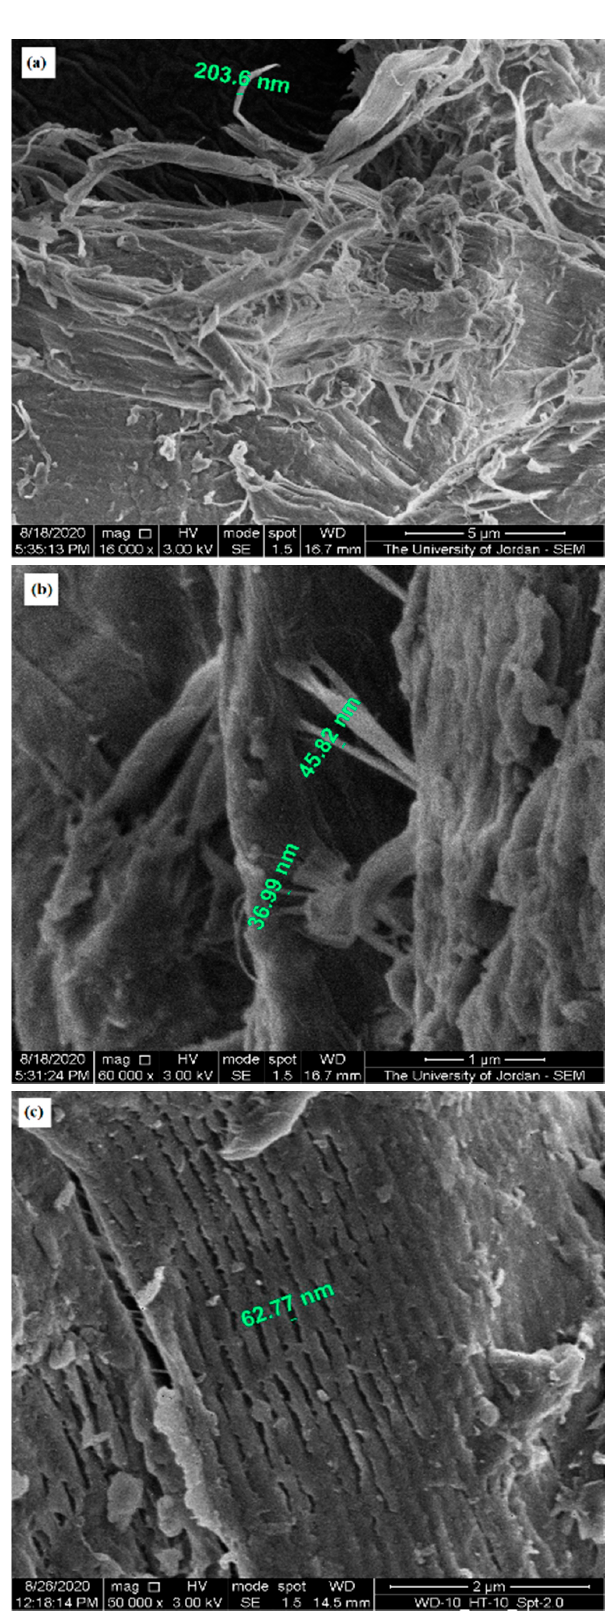
Figure 6. SEM image with measurement of fiber thickness of ( a ) shrimp (CH-Sh) CH at 16,000× magnification, ( b ) shrimp (CH-Sh) CH at 60,000× magnification, and ( c ) squid (CH-Sq) CH at 50,000× magnification.